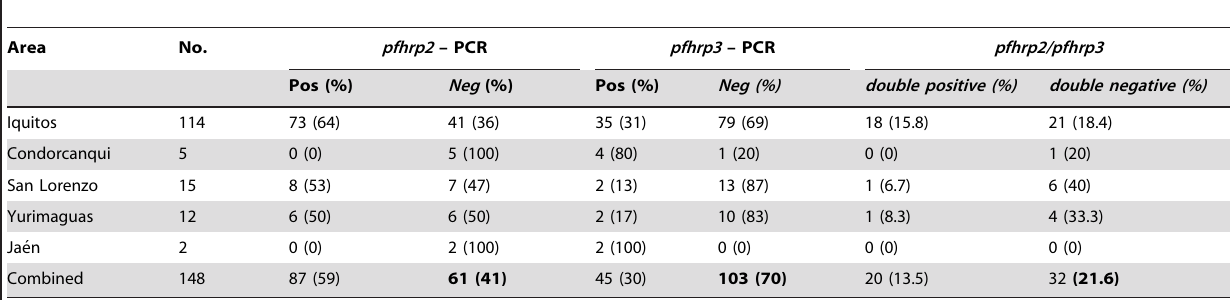
Table 4. Proportion of P. falciparum isolates positive or negative for pfhrp2/3 genes in different areas of the Peruvian Amazon.